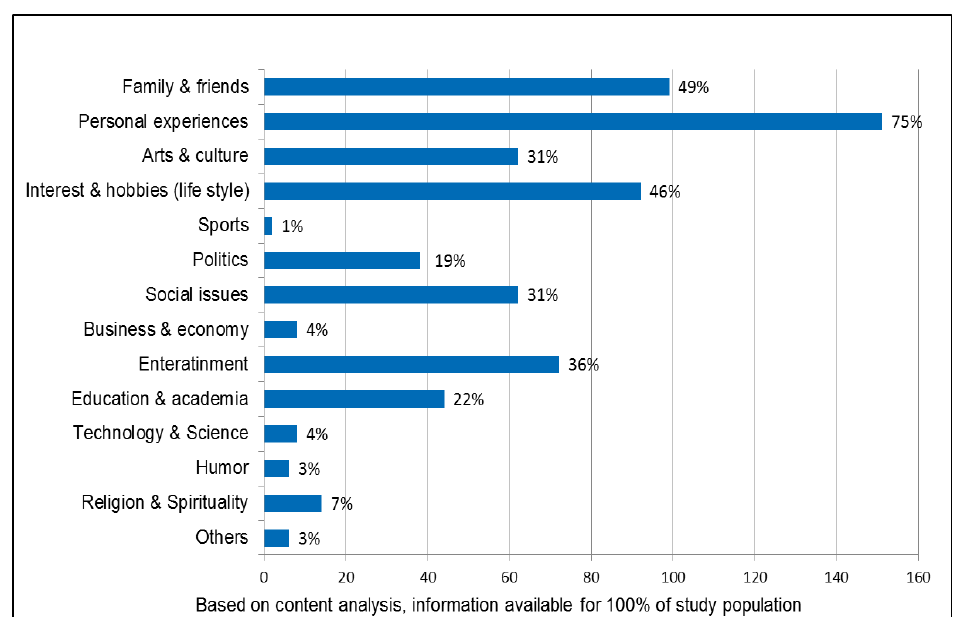
Figure 4: Issues Blogged about by Number of